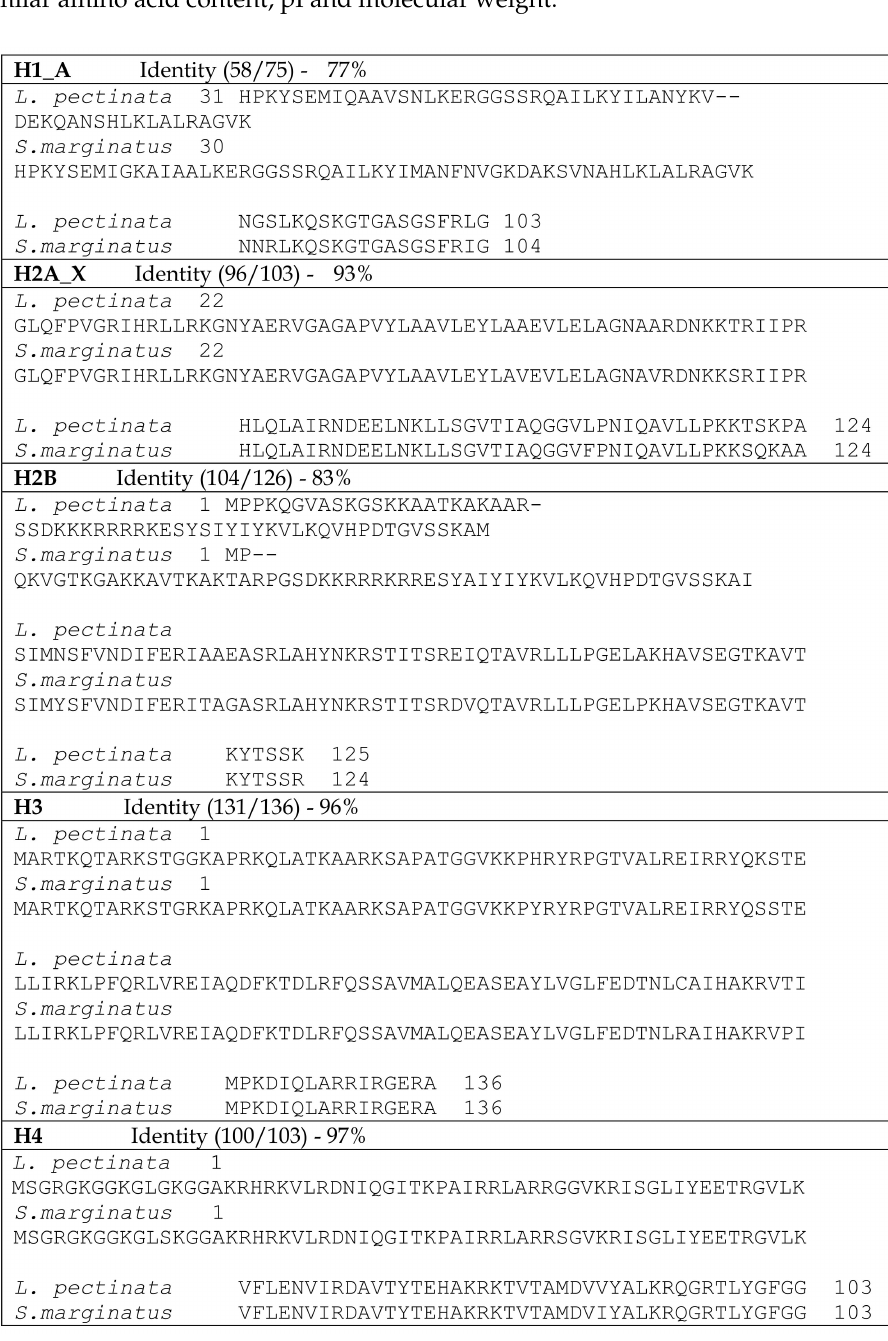
Figure 1. BLASTP alignments between histone protein sequences from Lucina pectinata and Solen marginatus . Areas of sequence identity are highlighted in